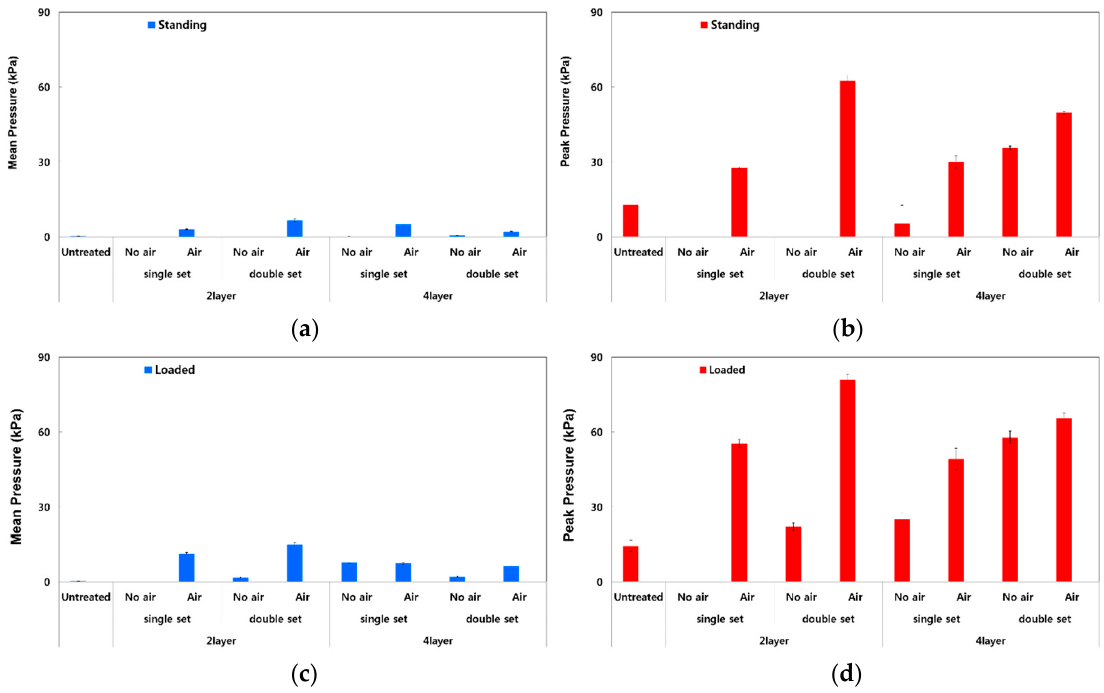
Figure 8. Contact area measurements for ( a ) standing, ( b ) loaded, ( c ) front-loaded and ( d ) back-loaded postures.